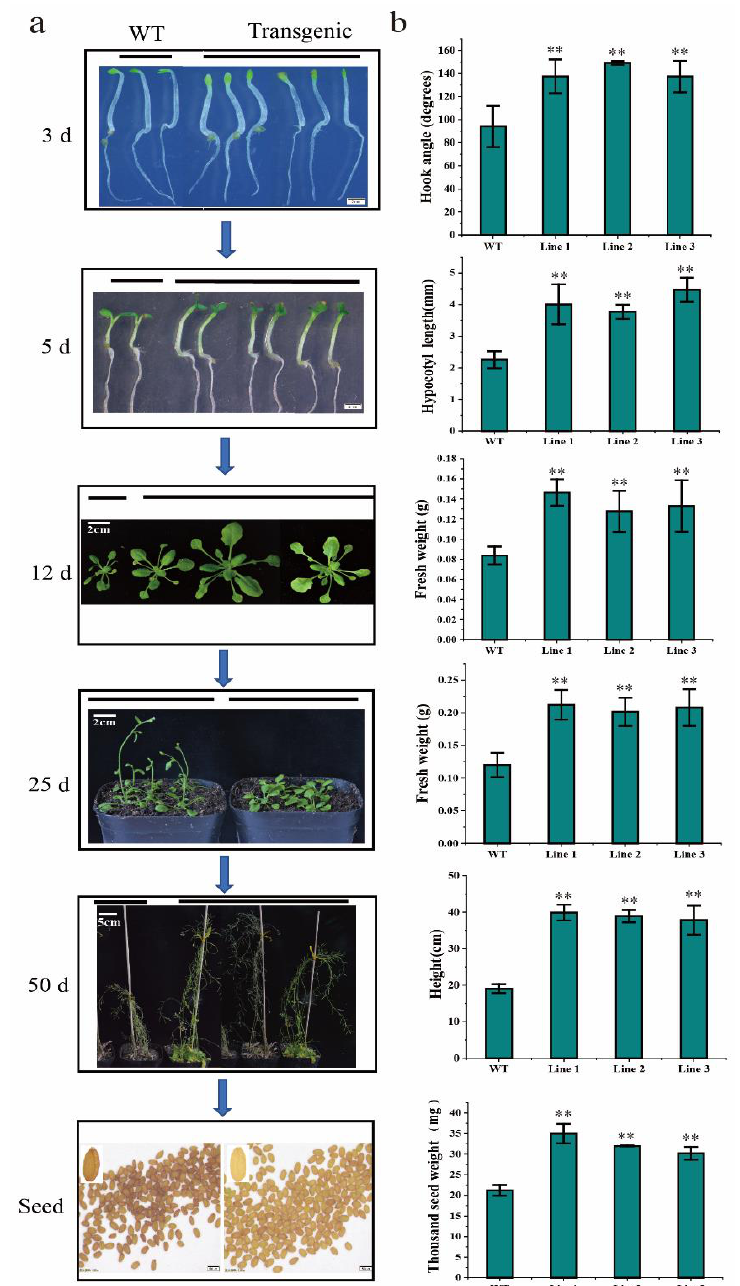
Figure 6. BaZFP1 positively regulates Arabidopsis growth and development. ( a ) Gross morphology of the wild type and transgenic lines at different developmental stages. ( b ) Statistical analysis of thousand-seed weight, hook angle, hypocotyl length, fresh weight, and plant height at different growth stages. Seeding stage: growth in MS medium for 3 and 5 days. Growing stage: growth in nutrient soil for 12, 25, and 50 days. Three independent biological replicates were performed, and vertical bars refer to ± SD (n = 3). Asterisks indicate significant differences between WT and transgenic lines (* p < 0.05; ** p < 0.01).